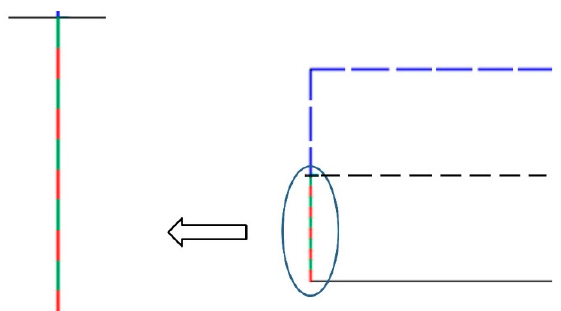
Figure 8. Imposition region of the prescribed velocity boundary conditions for wave generation through discrete transient data [26].